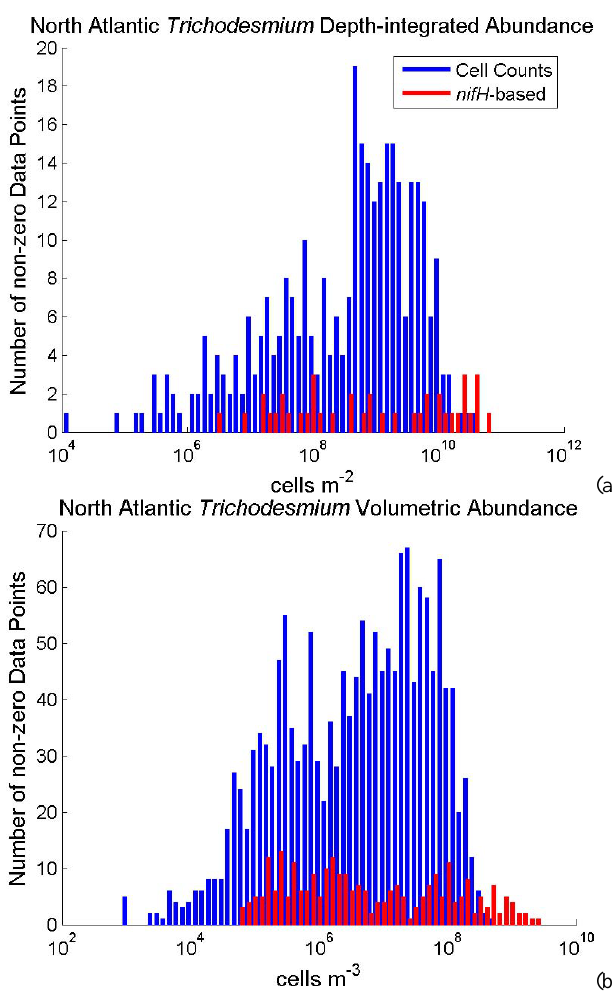
Figure 7. Histogram of depth-integrated (panel a ) and volumet- ric (panel b ) non-zero data points of cell-count-based (blue) and nifH -based (red) Trichodesmium abundances in the North Atlantic (10 ◦ S–50 ◦ N). Each Trichodesmium trichome is assumed to be comprised of 100 cells. Data values are on logarithmic scale. Those “detected but not quantifiable” nifH -based abundances, which are assigned 10 × 10 3 cellsm − 3 (see text for details), are not